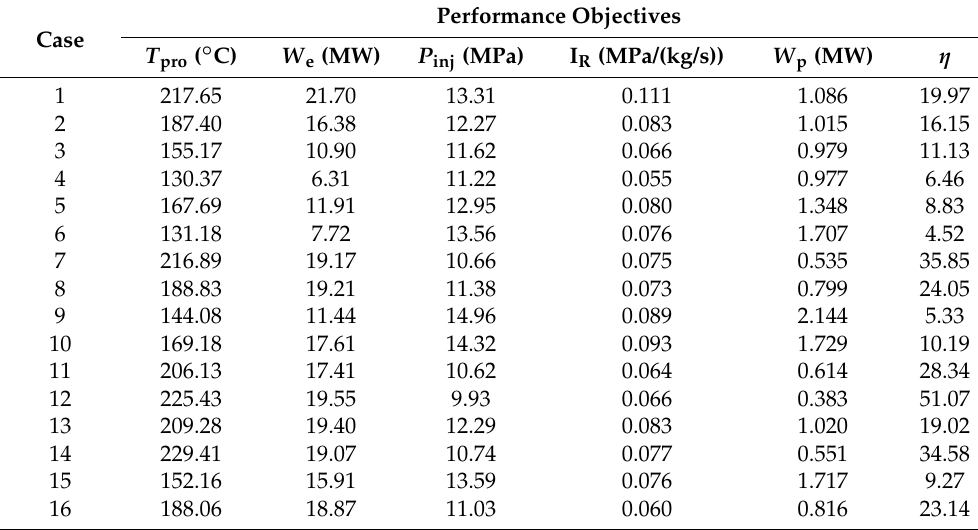
Table 4. The electricity generation performance of the 16 geological models at t = 20 year. Production temperature ( T pro ); electric power ( W e ); injection pressure ( P inj ); reservoir impedance ( I R ); pump power ( W p ), and; energy efficiency ( η ).